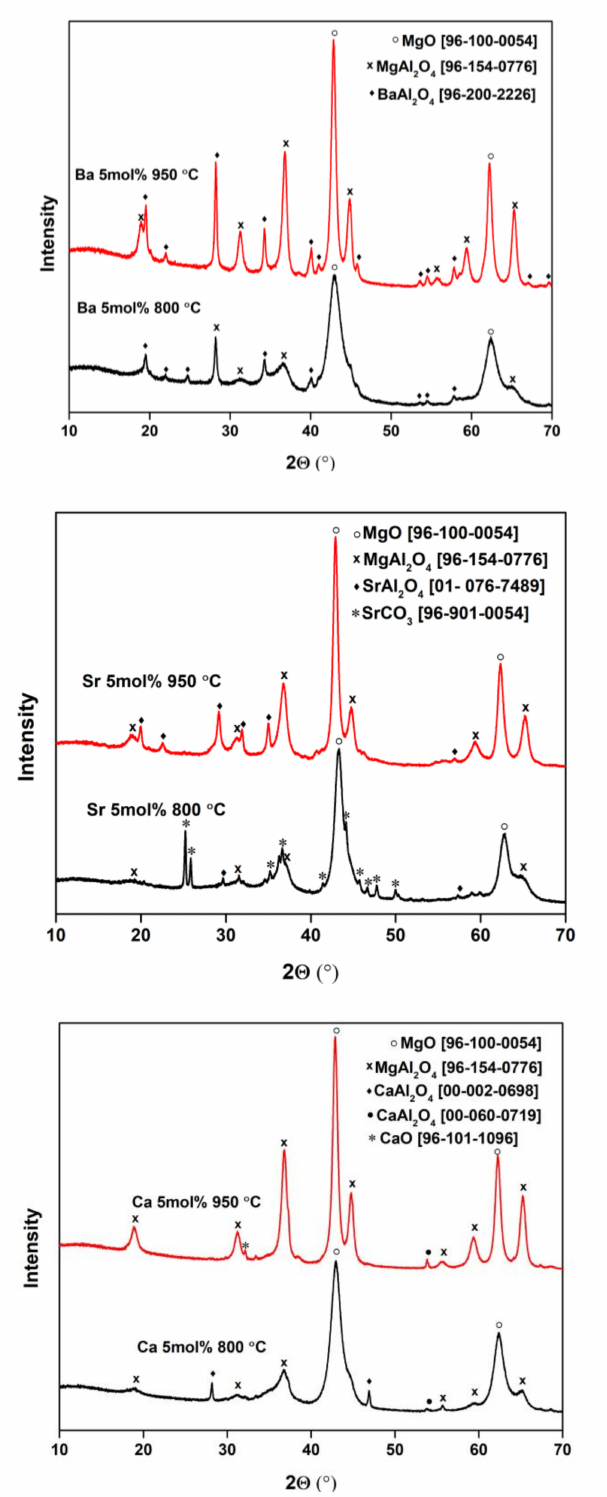
Figure 7. XRD patterns of mixed metal oxides (MMO) obtained by heating the Mg 1.95 Ca 0.05 / Al 1 LDHs ( bottom ), Mg 1.95 Sr 0.05 / Al 1 LDHs ( middle ), and Mg 1.95 Ba 0.05 / Al 1 LDHs ( top ) at di ff erent temperatures. The interplanar spacings and lattice parameters of sol–gel derived Mg 2 − x M x / Al 1 (M = Ca, Sr and Ba) LDHs with standard deviations in parentheses are presented in Table